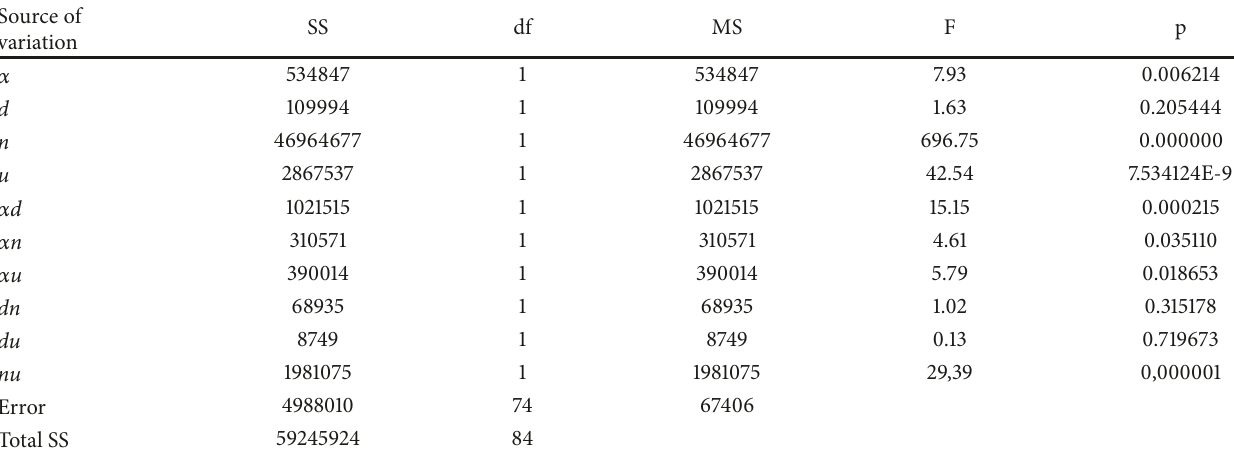
Table 5: Analysis of variance results of the model of specific energy consumption of the extruder E jc , where the coefficient of determination is equal to R 2 =0.92 and its corrected value is R 2 adj =0.90. SS: sum of squares, df: number of the degrees of freedom, MS: mean sum of squares, F: values of the test statistic, p: value of probability corresponding to the test statistic value.